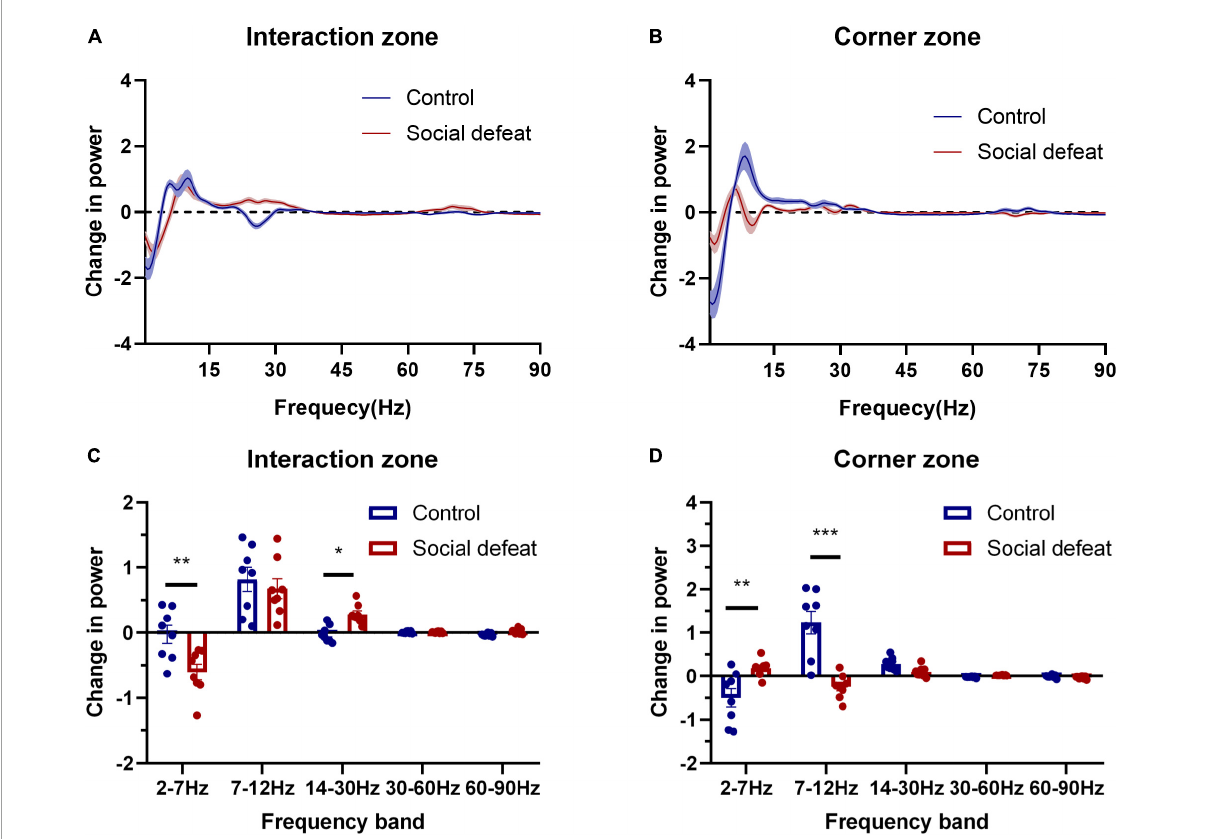
FIGURE4 Oscillations in different frequency ranges are associated with social avoidance. (A) Change in power in the interaction zone. (B) Change in power in the corner zone. (C) The two groups showed statistical differences in the interaction zone ( F (1,7) = 5.483, * p < 0.05, two-way ANOVA, post hoc comparisons with Bonferroni’s test). Note the 2–7 Hz oscillation of the socially defeated mice showed a negative change while 14–30 Hz oscillation showed a positive growth, compared with controls (* p < 0.05, ** p < 0.01). (D) The two groups exhibited statistical differences in the corner zone ( F (1,7) = 6.088, * p < 0.05, two-way ANOVA, post hoc comparisons with Bonferroni’s test). Note the 2–7 Hz and 7–12 Hz oscillations of the socially defeated mice experienced relatively minor changes (** p < 0.01, *** p <